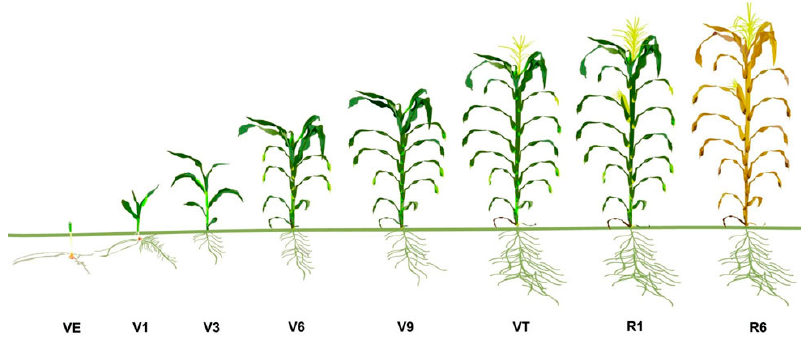
Figure 7. Phenological stages of cornfield growth (Figure adapted from Figure 1 in [48]).